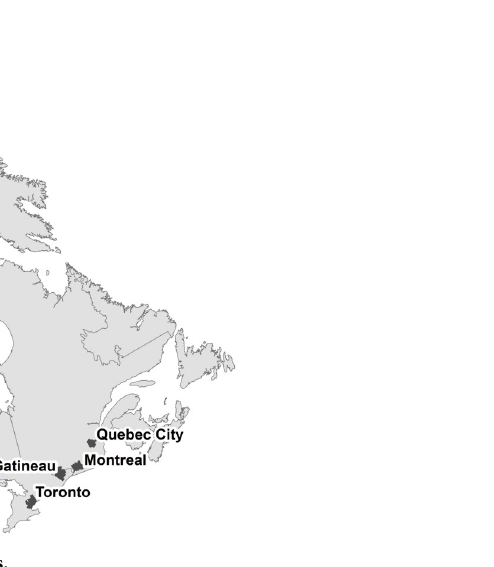
Fig 1. Locations of Canada’s eight largest